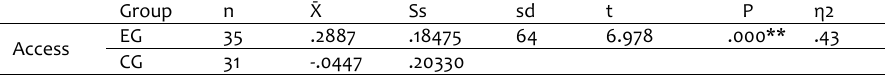
Table 1. Analysis Results Regarding Narrative Text Writing Skills Achievement